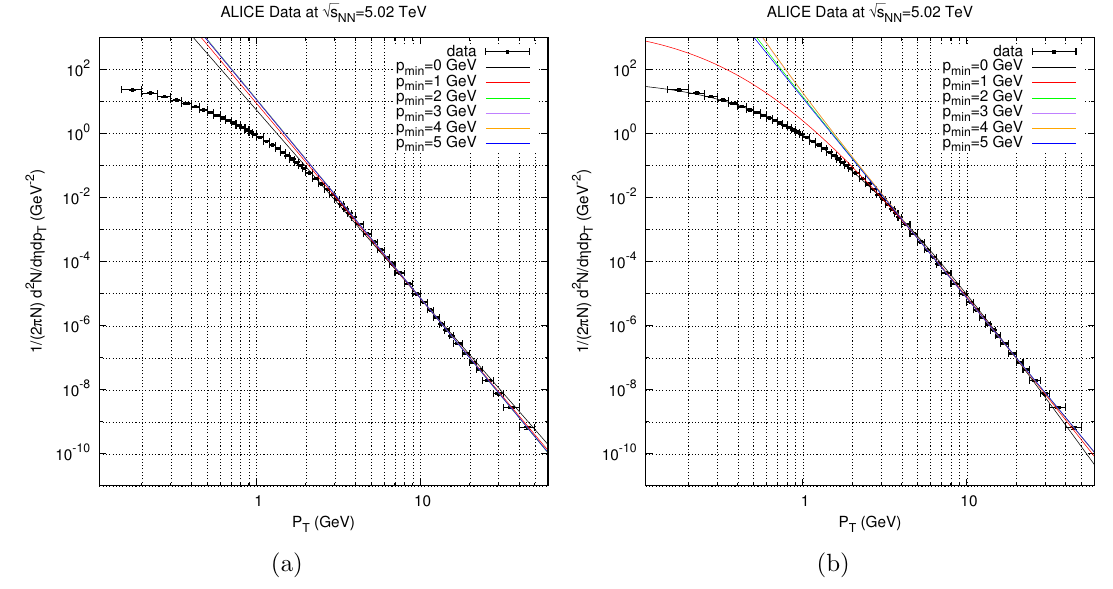
Figure 12. Fit of the two parameter ansatz in eq. (E.2) (left) and the three parameter ansatz in eq. (E.3) to the ALICE dataset at p s = 5 : 02 TeV in the